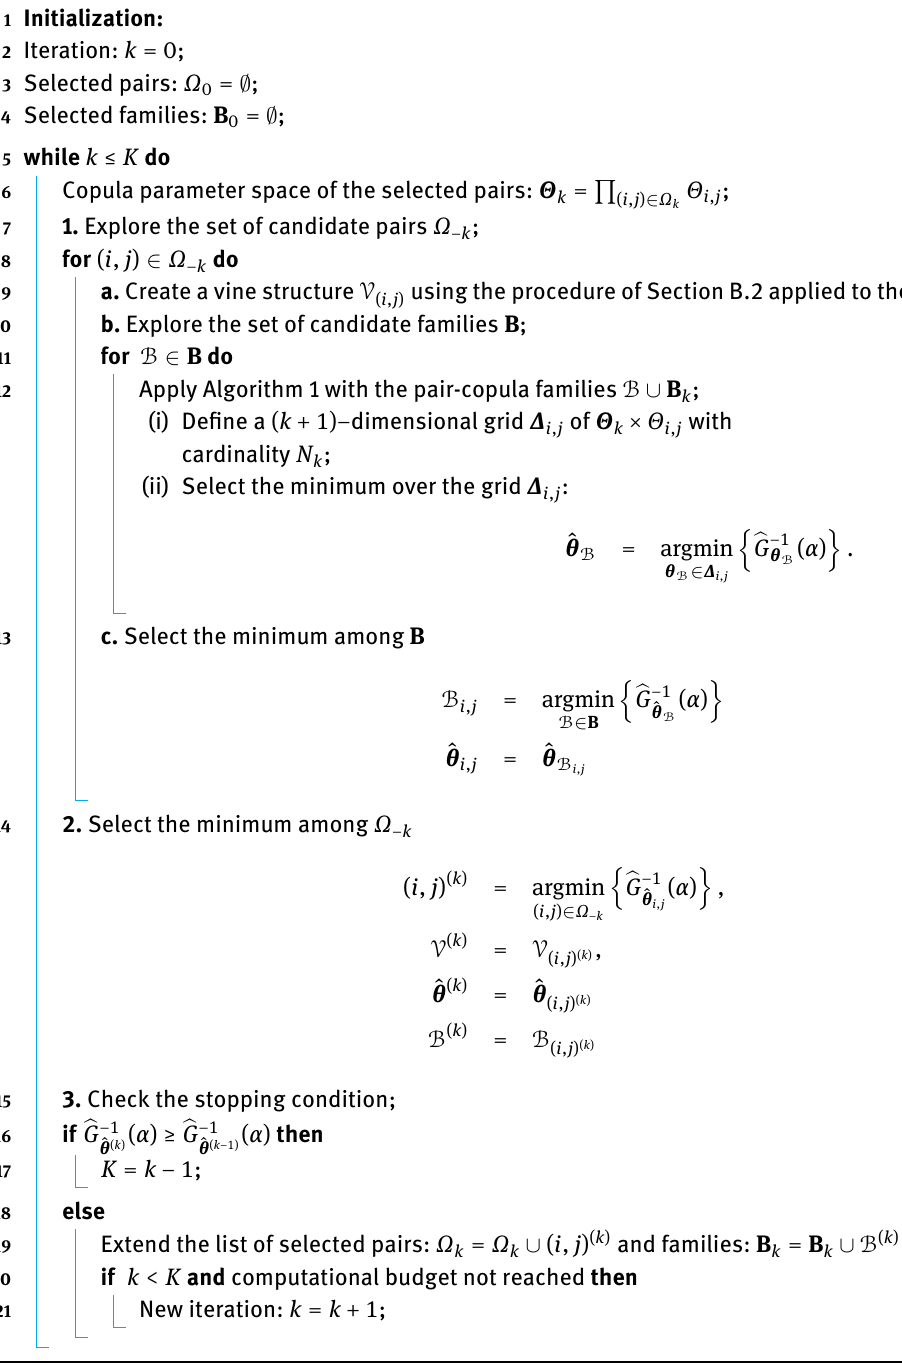
Algorithm 2: Minimization of the output quantile and estimation of θ ( K ) over an increasing family of R-vine